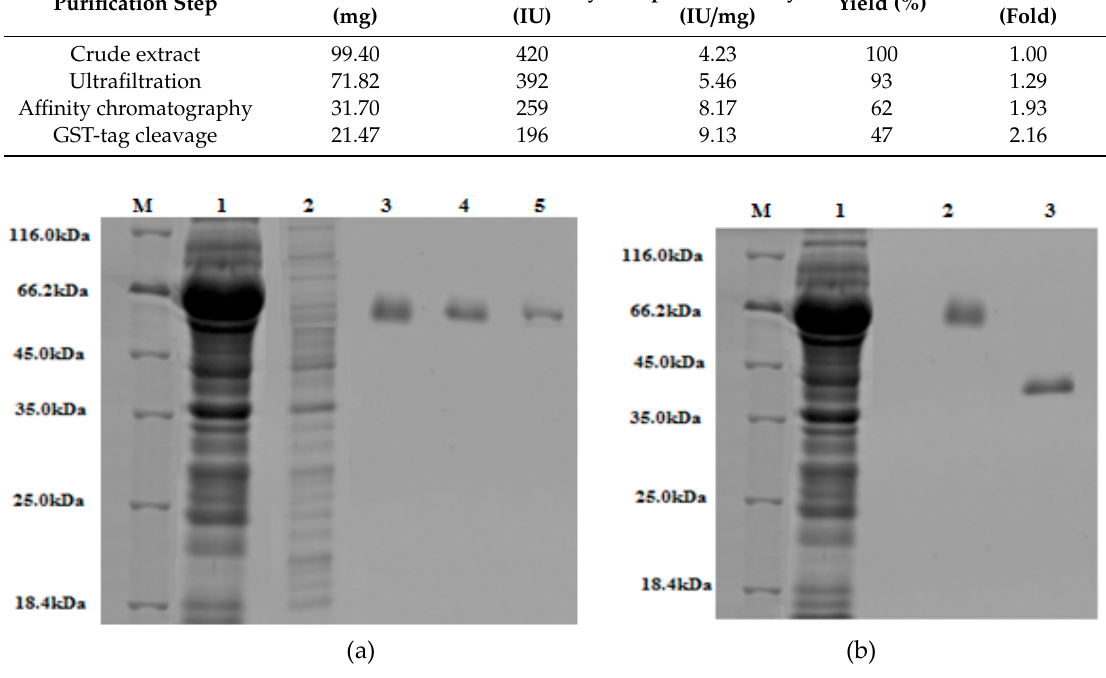
Figure 7. The 10% (w/v) SDS-PAGE gels stained with Coomassie Brilliant Blue: ( a ) Lane M, protein marker (18.4–116 kDa); lane 1, crude extract; lane 2, run-through; lane 3, 4, 5, are elute one, two, and three of purified GST-tagged β -glucosidase, respectively. ( b ) Lane M, protein marker (18.4–116 kDa); lane 1, crude extract; lane 2, purified GST-tagged β -glucosidase; lane 3, purified β -glucosidase (post GST-tag cleavage).